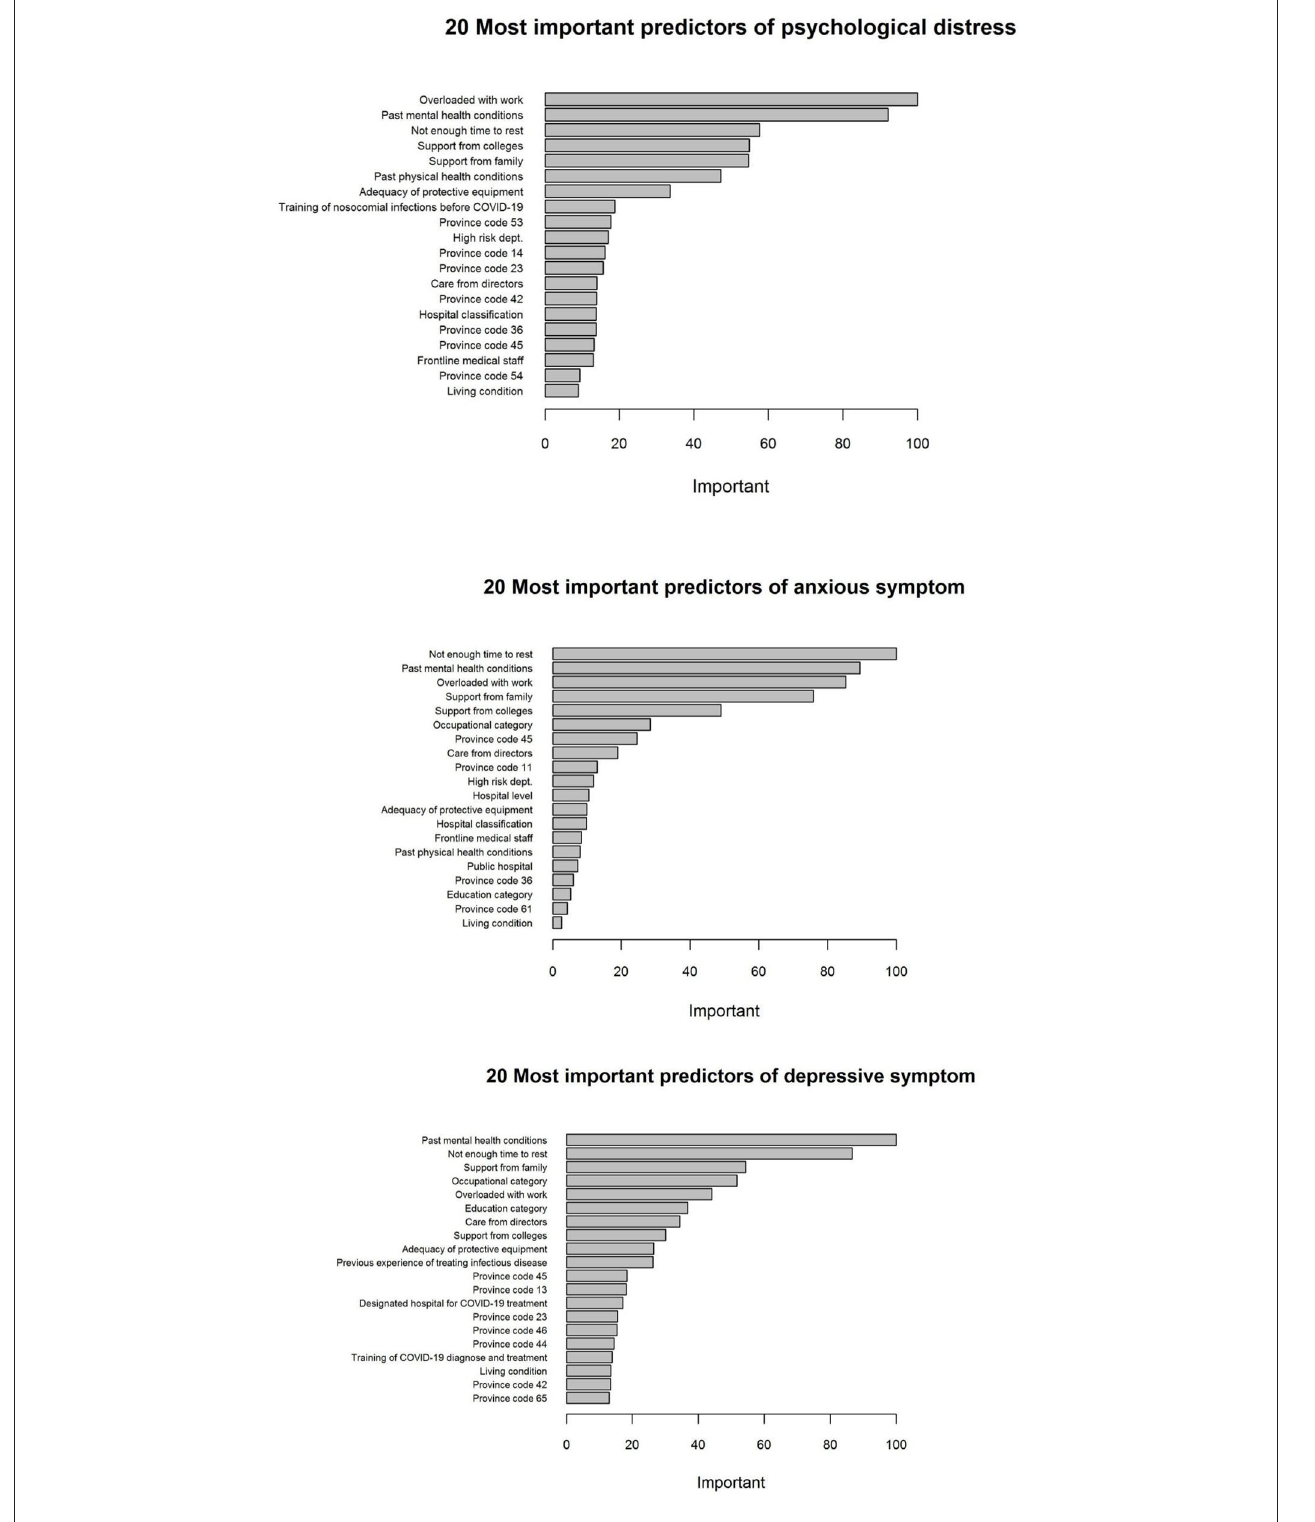
FIGURE 2 | Twenty most important predictors of the symptoms of common mental disorders based on the Elastic Net models.